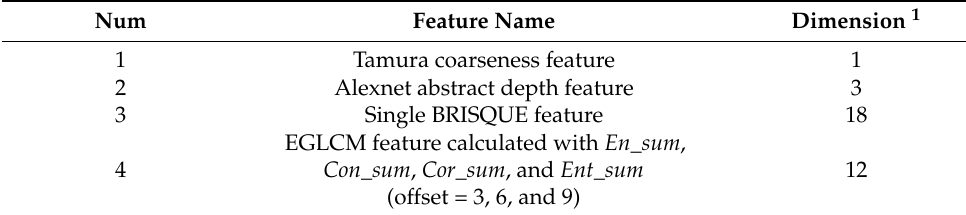
Table 2. Input feature name and dimension of SVR.